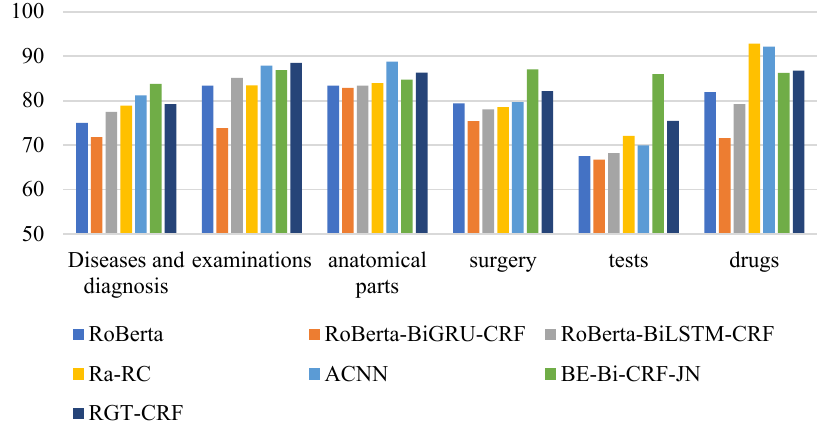
Figure 13. F1 values of different entities on CCKS2017 for different models.